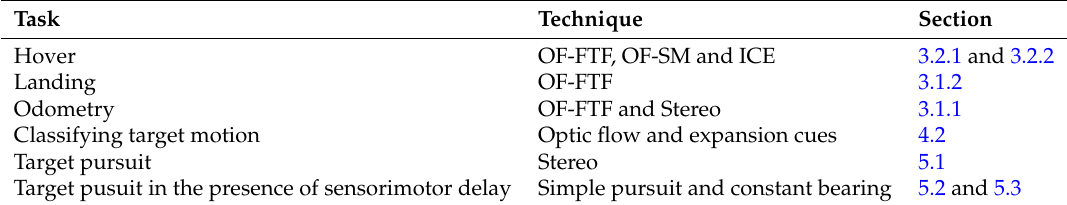
Table 4. Summary of tasks described in this paper and the corresponding techniques used to achieve